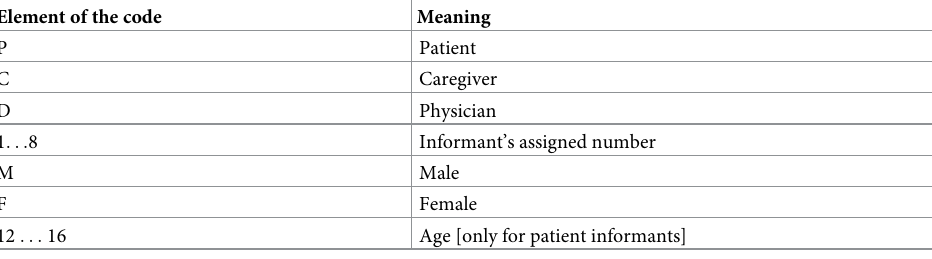
Table 2. Informant codes. Element of the